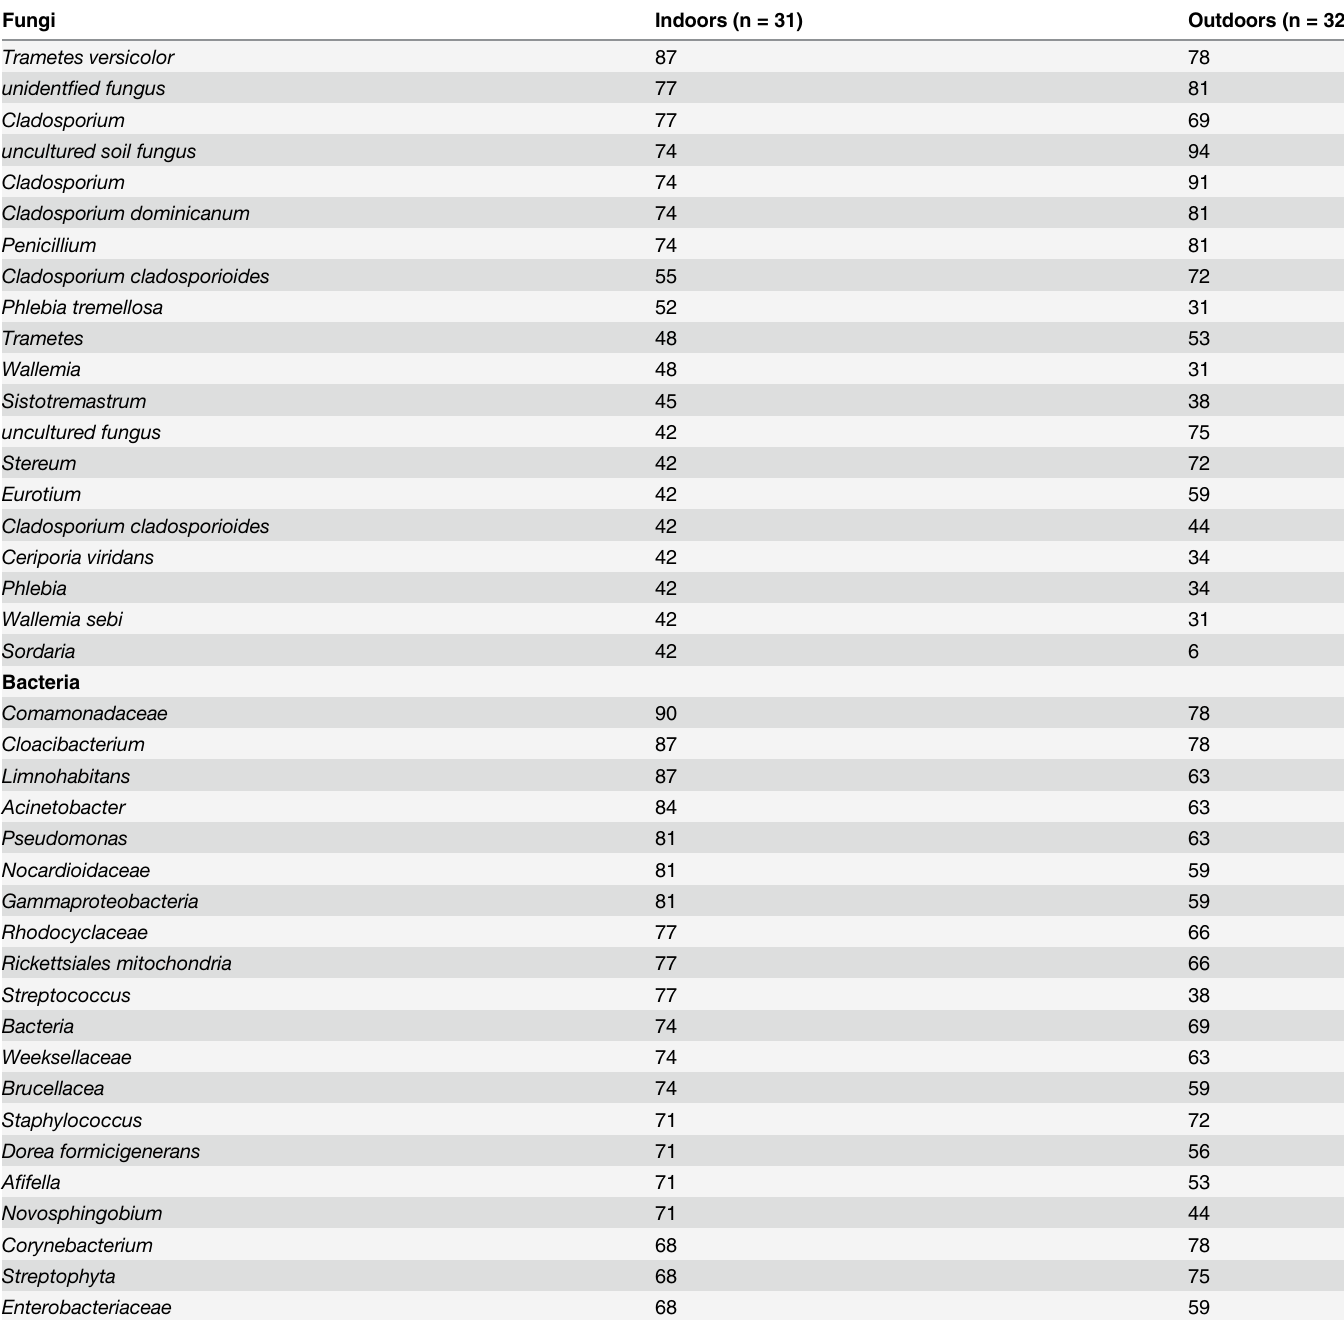
Table 1. Most frequently encountered